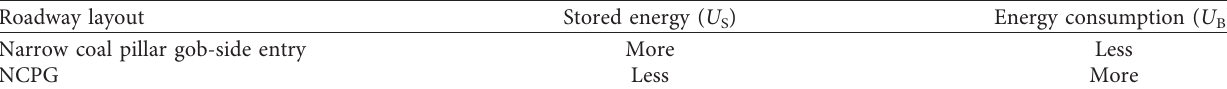
Table 4: Qualitative comparison of